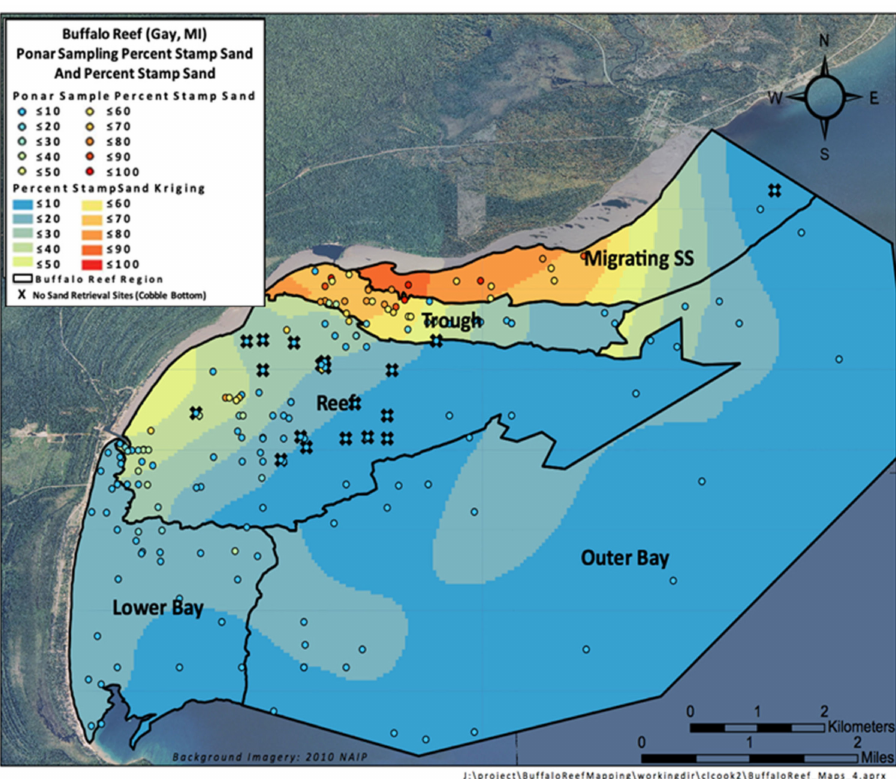
Figure 15. ArcGIS Contouring using strong barrier effects. Contours are constructed based largely on point values within the five sub-regions. This option reduces the number of control points, but considers strong bathymetric boundaries, such as found in the